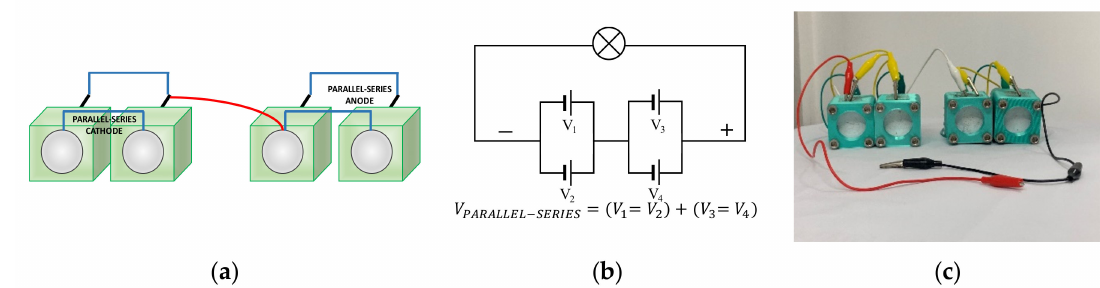
Figure 7. Parallel/series-based configuration: ( a ) scheme, ( b ) electrical connection mode and ( c ) stacked MFCs tested in lab.